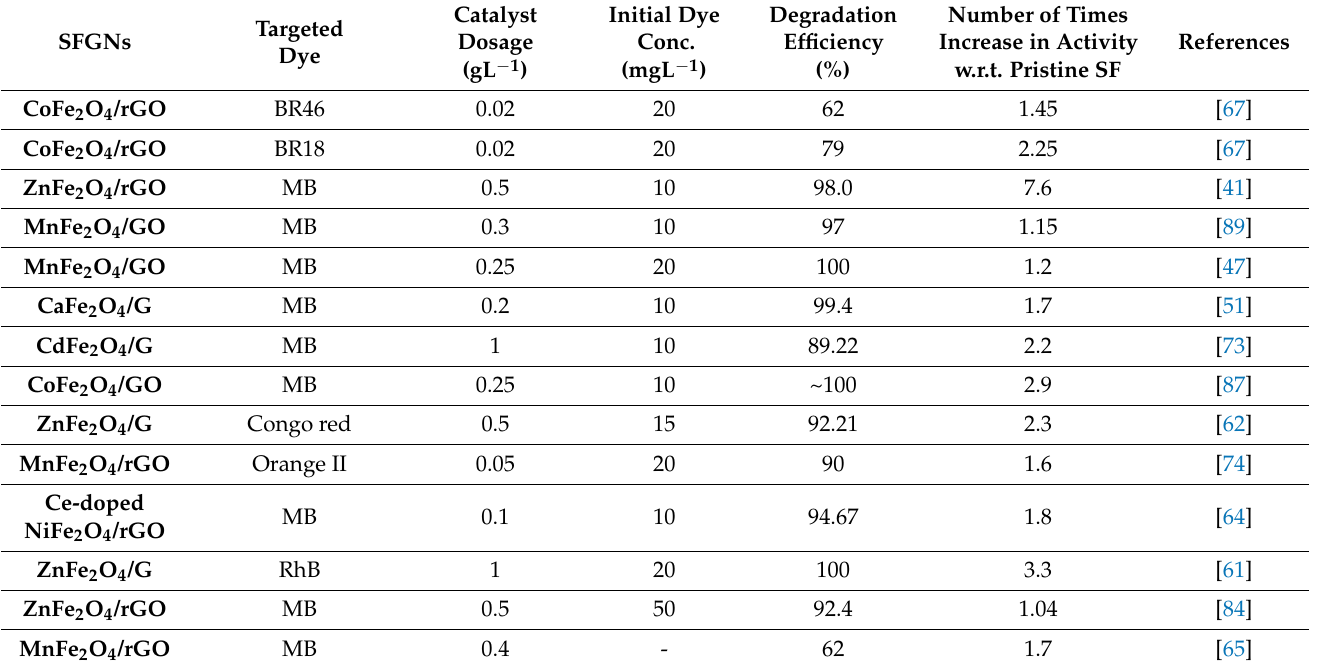
Table 1. Comparison in performance of MFGNs for photocatalytic-dye detoxification with pristine